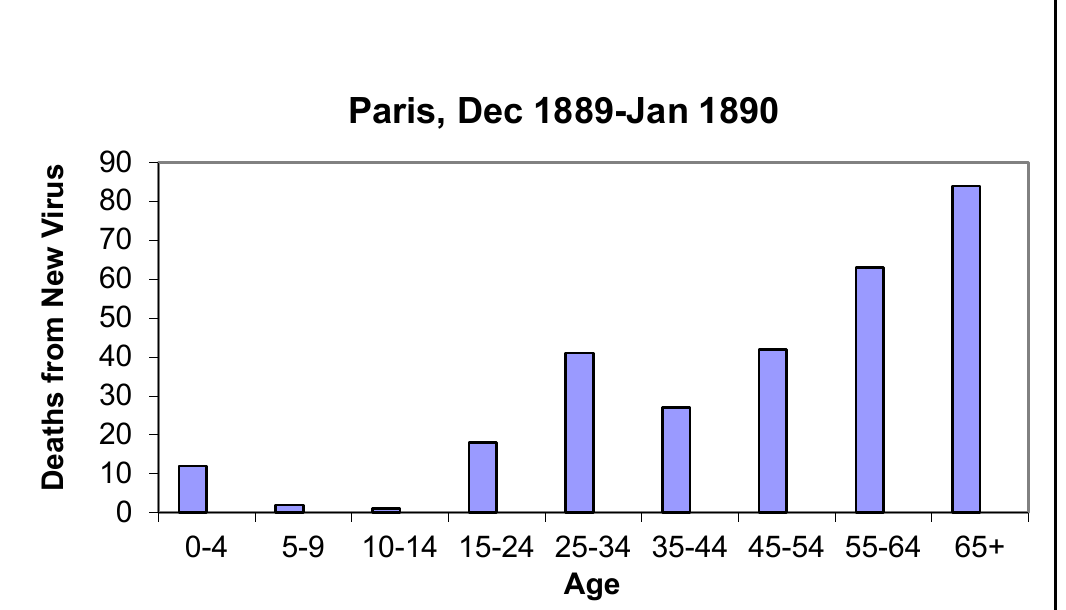
Figure 3. Ages of those who died of the new virus, diagnosed as ‘grippe’, in Paris from December 1889 to January 1890. Source: “Annuaire statistique de la ville de Paris”